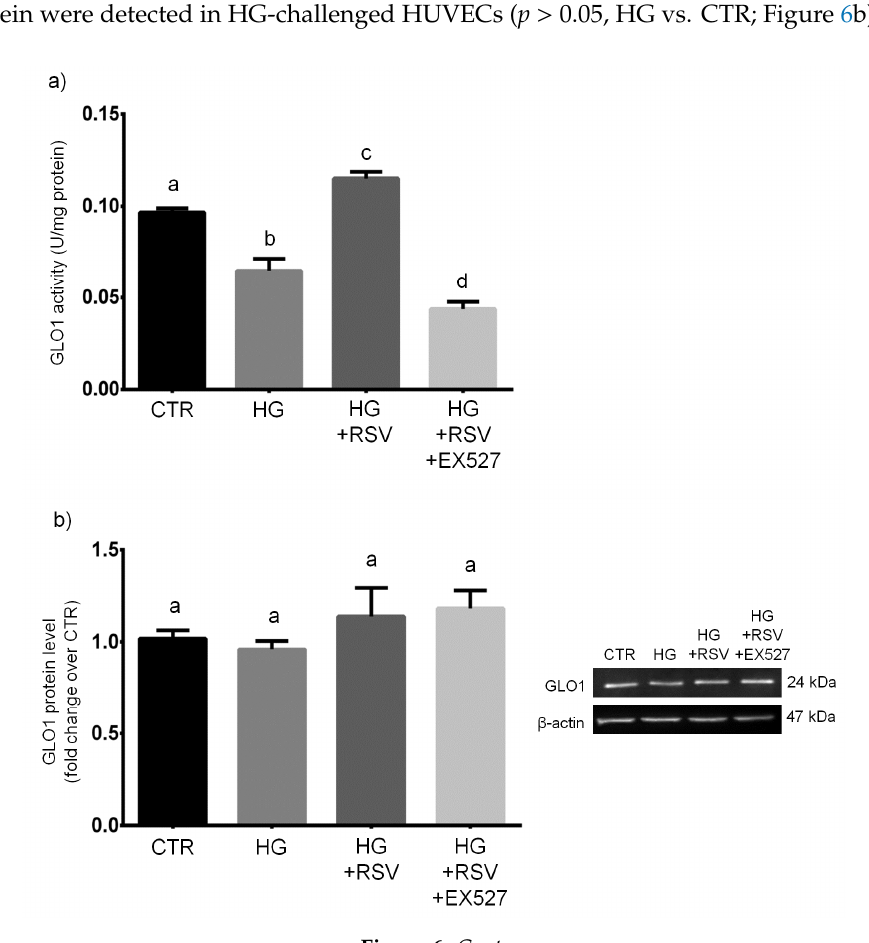
Figure 6. Effects of a 24-h treatment with either resveratrol alone (5 µM) or resveratrol+EX527 (5 µM and 13.4 µM, respectively) combination on the enzymatic activity ( a ), protein levels ( b ), as well as mRNA content ( c ) of GLO1 in high glucose-challenged HUVECs. Representative blots are also shown ( b ). Data are expressed as means and S.E.M. Abbreviations: CTR—vehicle; HG—high glucose; HG + RSV—high glucose + resveratrol; HG + RSV + EX527—high glucose + resveratrol + EX527; GLO1—glyoxalase 1. Means sharing the same letter are not significantly different from each other (one-way ANOVA and Tukey’s multiple comparisons test): Panel a: a vs. b, p < 0.01; b vs. c, p < 0.001; a vs. c, p < 0.05; b vs. d, p < 0.05; a vs. d, p < 0.001; c vs. d, p < 0.001 ( N = 4). Panel b: ( N = 4). Panel c: a vs. b, p < 0.001; b vs. c, p < 0.01; a vs. c, p < 0.001; a vs. d, p < 0.01; b vs. d, p < 0.001; c vs. d, p < 0.001( N = 5).